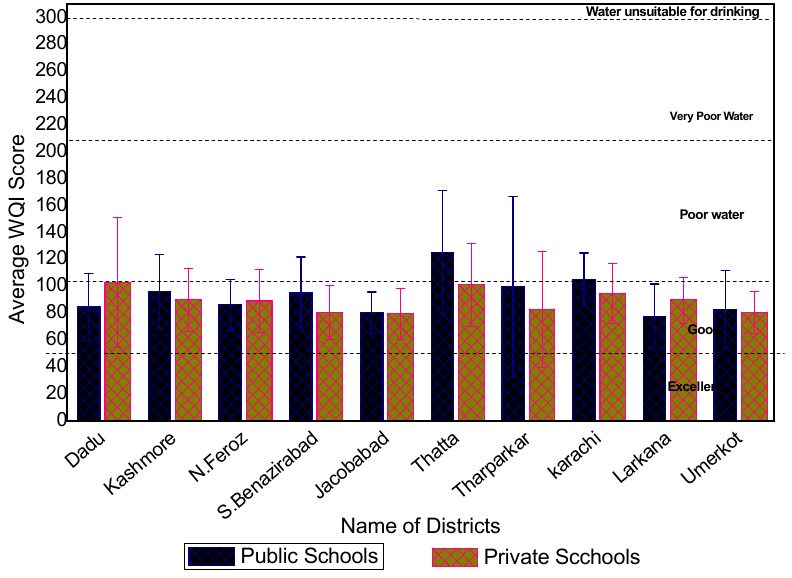
Figure 6. Water Quality Index (WQI) score comparison between private and public schools.